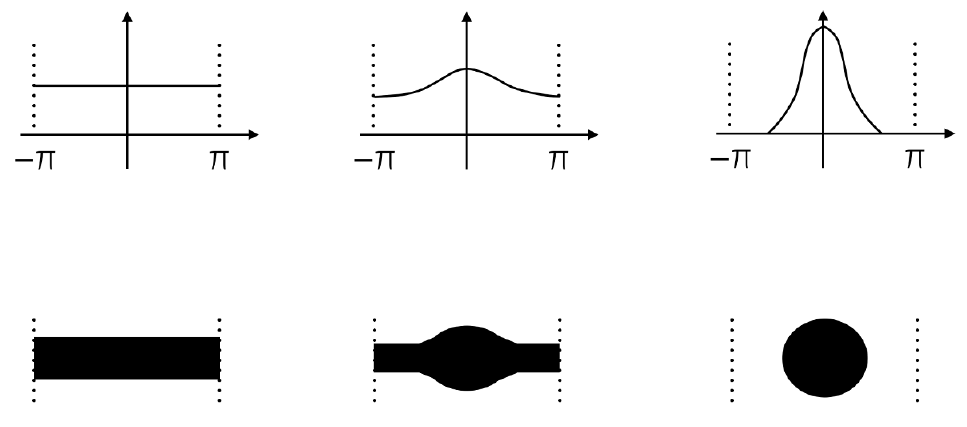
Figure 1 . The conjectured correspondence between the distribution of the phases of Wilson loop eigenvalues (top row) and the topology of the black hole/black string dual con(cid:12)gurations (bottom row), with black hole, uniform black string and wavy string con(cid:12)gurations corresponding to localized (\gapped"), uniform and nonuniform (\ungapped") phase distributions, respectively. Dotted lines indicate periodic boundary conditions on the circle. Figure adapted from ref.